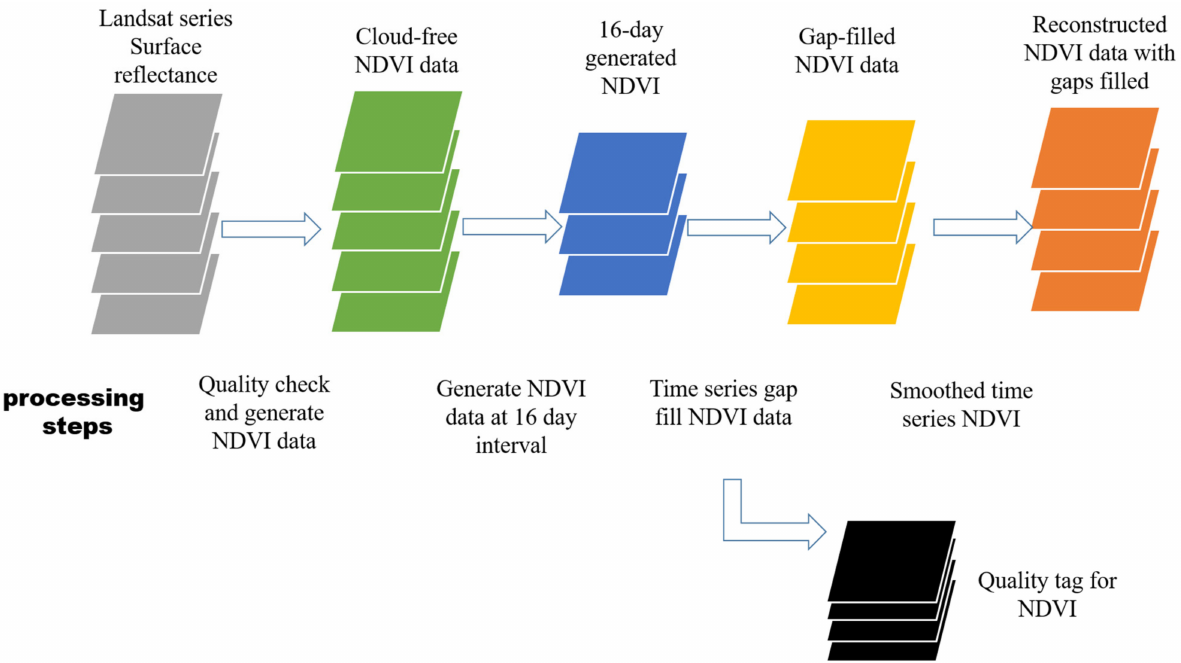
Figure 2. Workflow of reconstructed